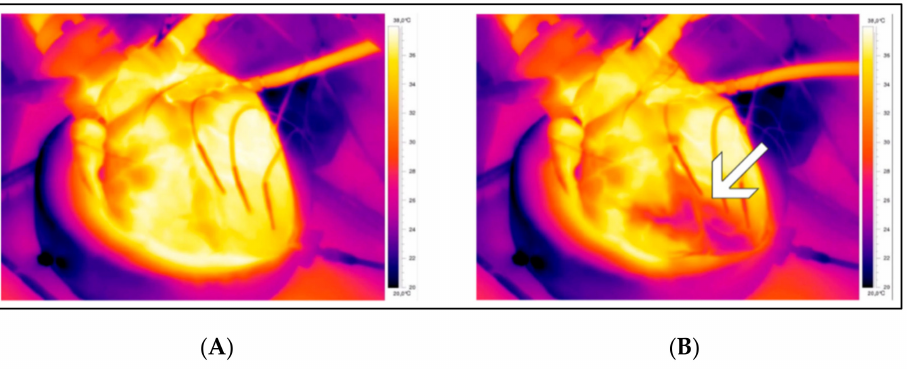
Figure 3. Visualization of the infarct area before ( A ) and during ( B ) selective intracoronary hy- pothermia in an ex vivo beating porcine heart. The arrow indicates the myocardium at risk (MaR) during selective intracoronary hypothermia. The decrease in myocardial temperature is limited to the borders of the MaR without affecting the temperature of the healthy adjacent